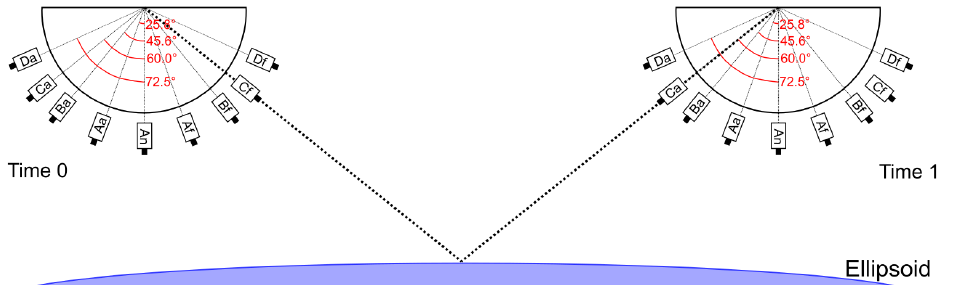
Figure 1. A schematic of the MISR instrument, illustrating near-simultaneous acquisition of multi- angular reflectance, shown here as referenced to an ellipsoid. The time interval between ‘Time 0’ and ‘Time 1’ (representing the Cf and Ca bands, respectively) is approximately five